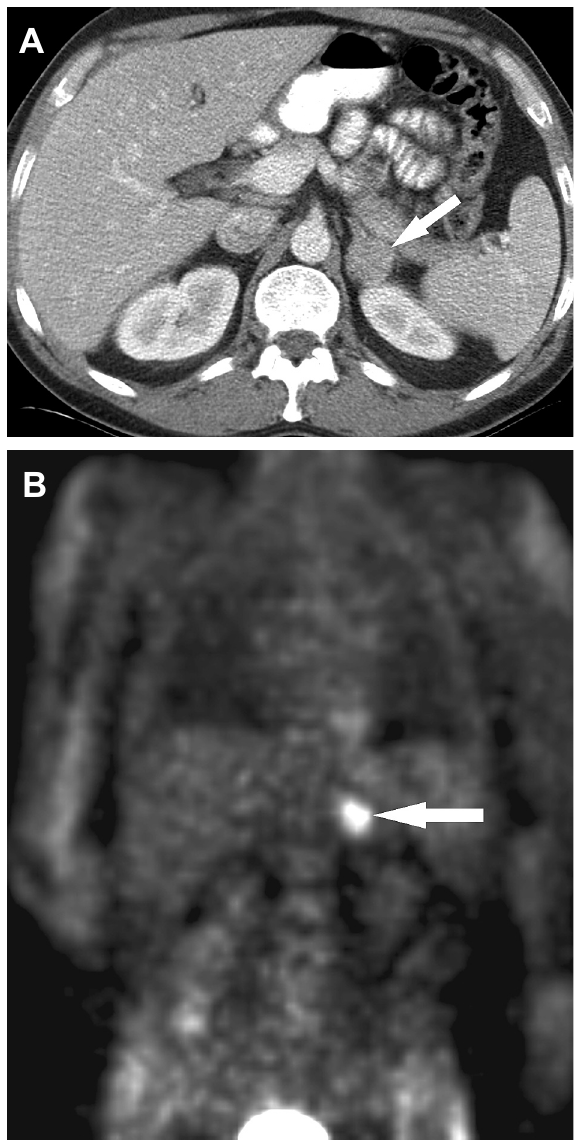
Figure 4 – Axial contrast-enhanced portal venous phase CT scan in a 25 year old woman undergoing re-staging of Hodgkin’s lymphoma previously treated by chemotherapy and radiotherapy (Case 4 in Table-1) shows a homogeneously enhancing right adrenal mass (arrow). The patient proceeded to laparoscopic adrenalectomy for suspected recurrent lymphoma, with an un- eventful intraoperative and postoperative course. Final pathology revealed a diagnosis of